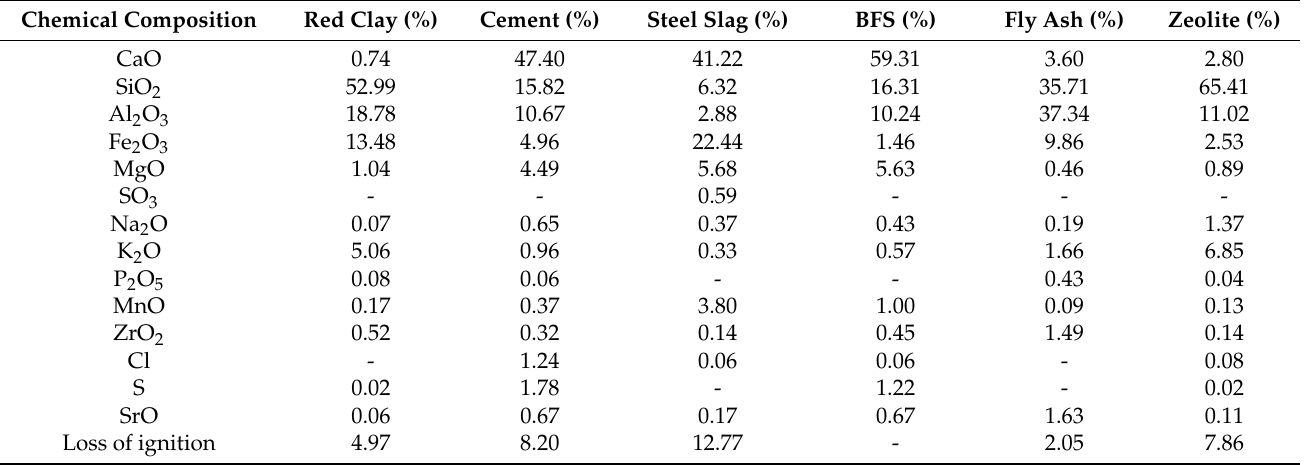
Table 2. Chemical properties of the red clay, cement, gypsum, steel slag, blast furnace slag, fly ash and